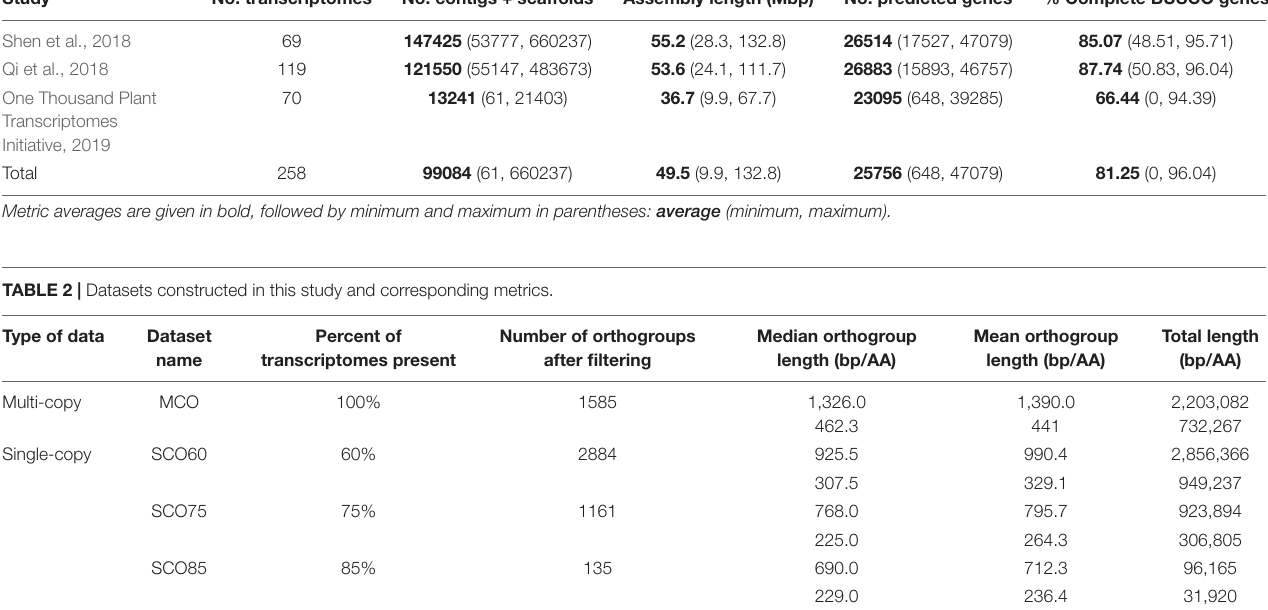
TABLE 1 | Assembly statistics for transcriptomes from three publications used in this study. Study